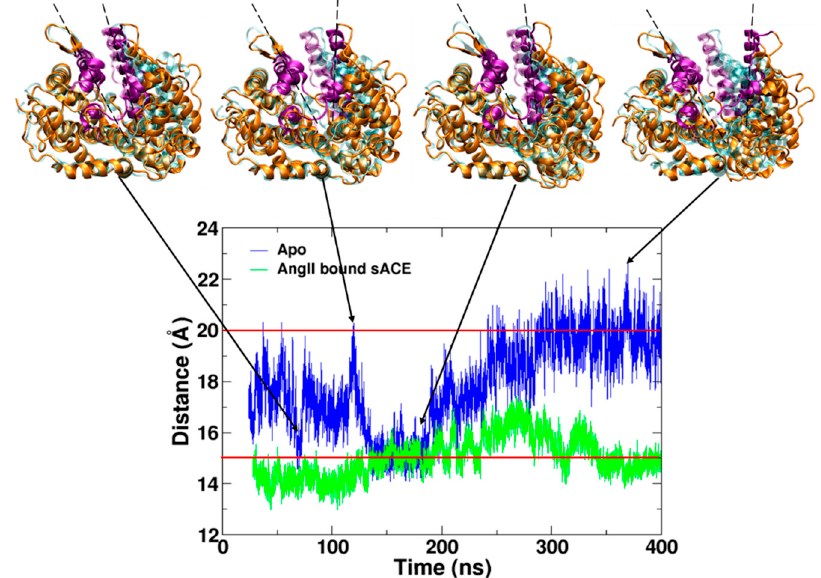
Figure 2. Distance between two lips of AngII bound sACE complex (green) and the Apo form (blue) along the simulation time after discarding the equilibration stage. A conformation with a distance between two lips longer than 20 Å is defined as the open state. With a distance shorter than 15 Å, the conformation is defined as the closed state. If the distance is between 15 and 20 Å, then the conformation is considered as the semi-open state. The snapshots of sACE (orange, purple for lips) are shown by superimposing the subdomain II to the crystal structure